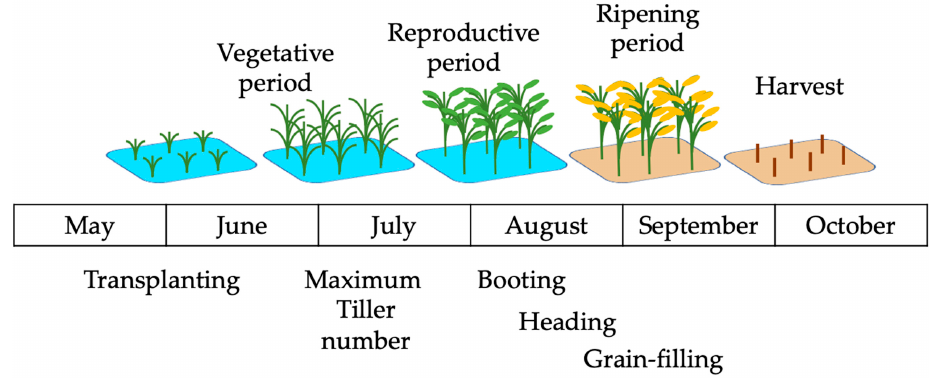
Figure 2. Rice crop calendar in Saku, Nagano, Japan.